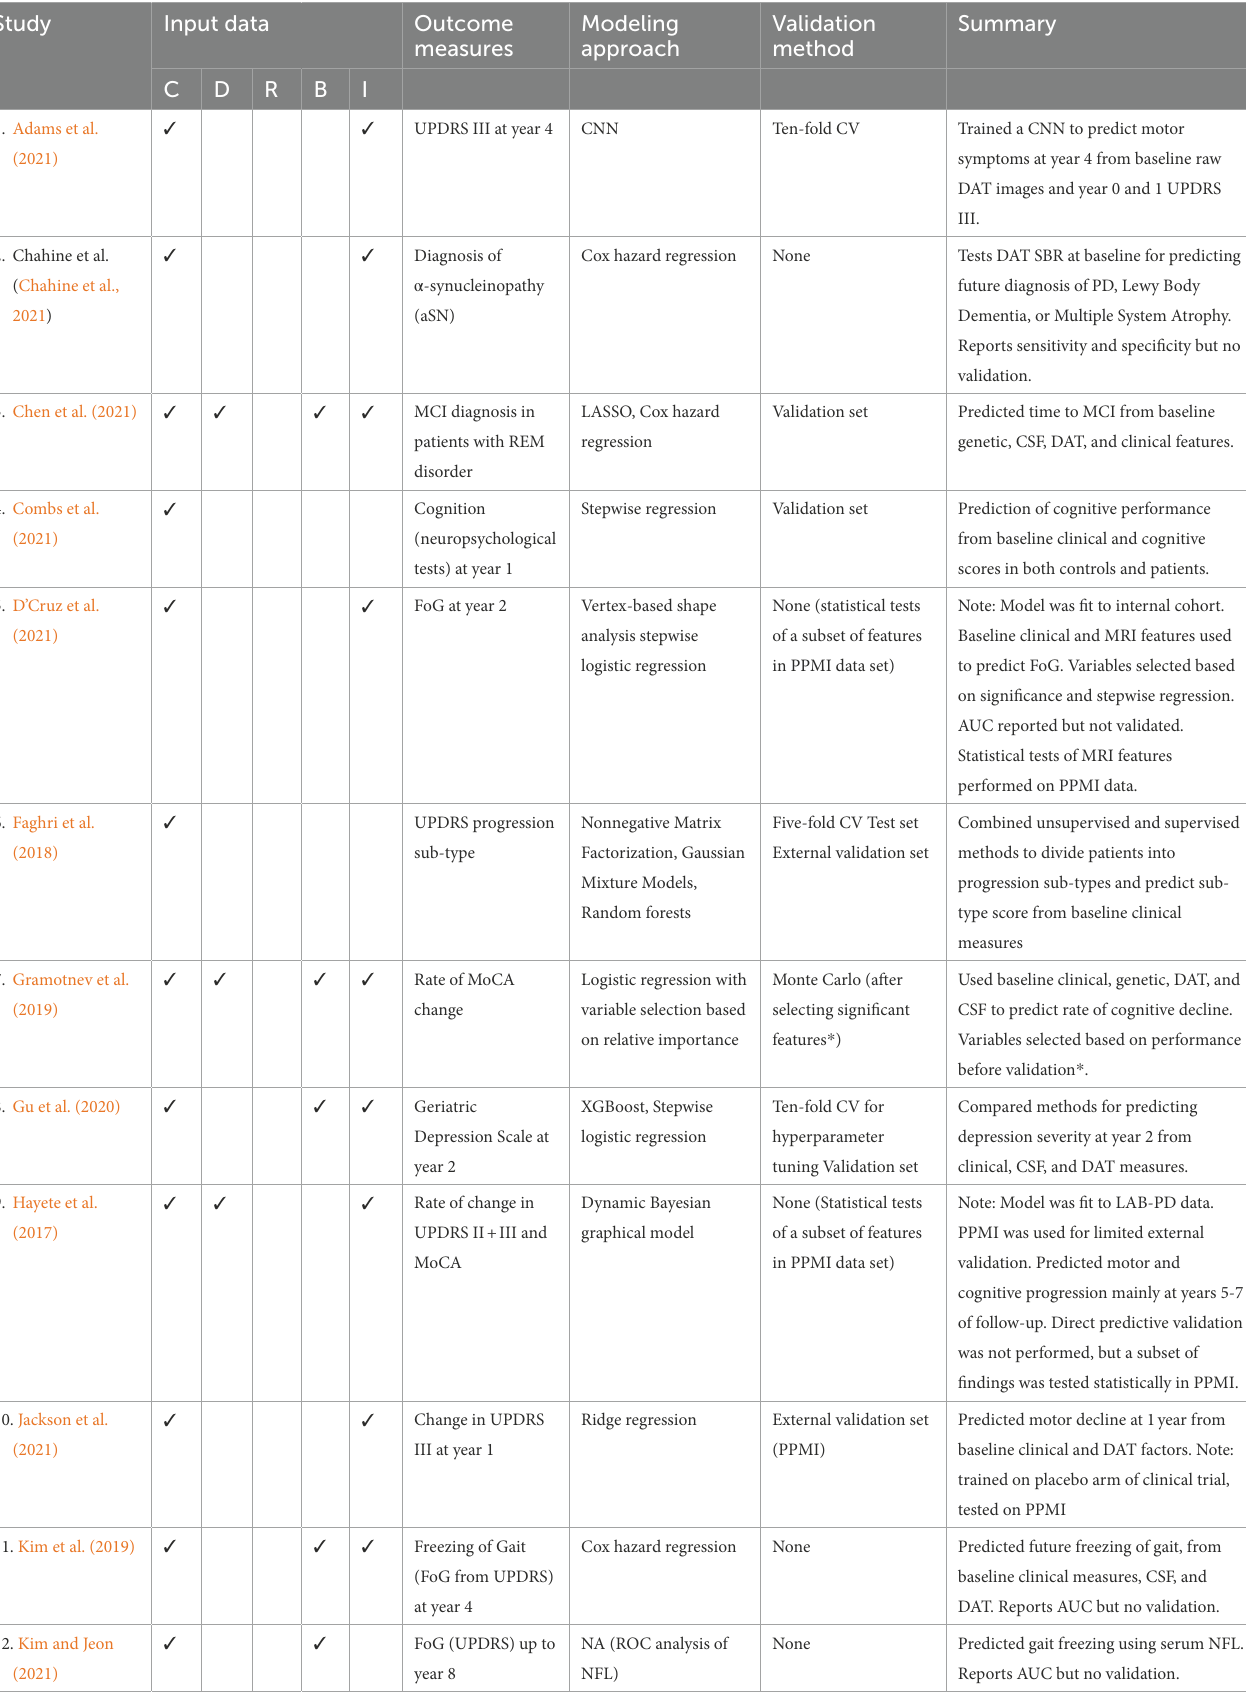
TABLE 1 Machine learning papers predicting symptom progression using the Parkinson’s Progression Markers Initiative data